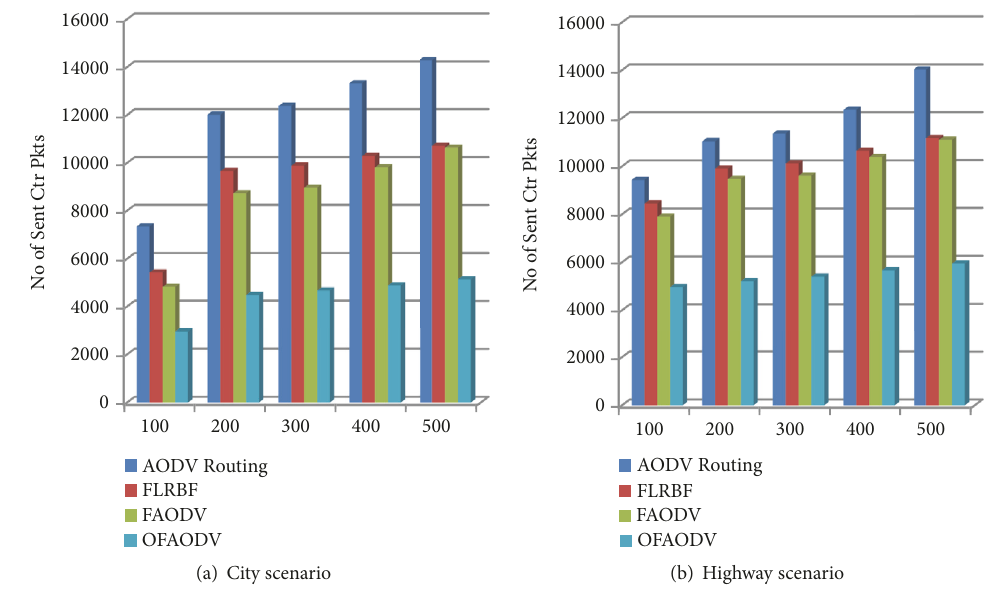
Figure 8: No. of sent control packets vs. no. of